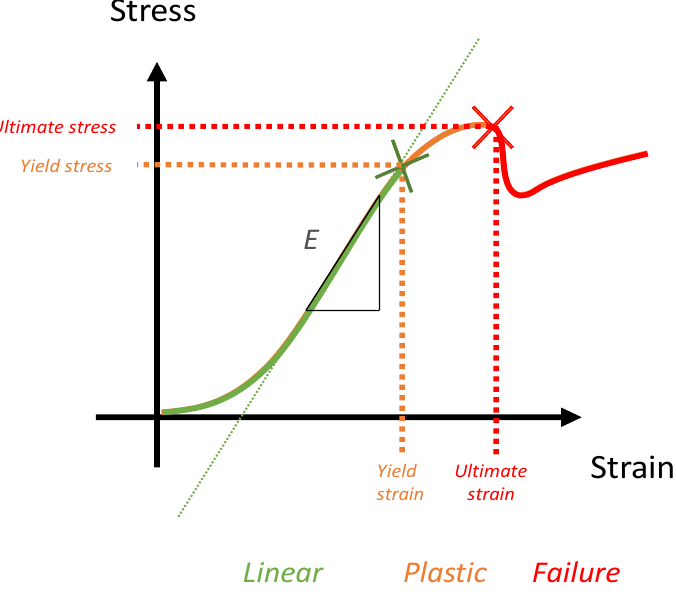
Figure 2. Biomechanics. An example of an idealized mechanical test curve. A load-displacement curve is transformed into a stress–strain curve with geometric parameters. The green part is the linear part corresponding to the elastic domain. The orange part corresponds to the plastic deformation domain. The ultimate stress (in red) corresponds to the failure but can only be numerically determined using a failure criterion.